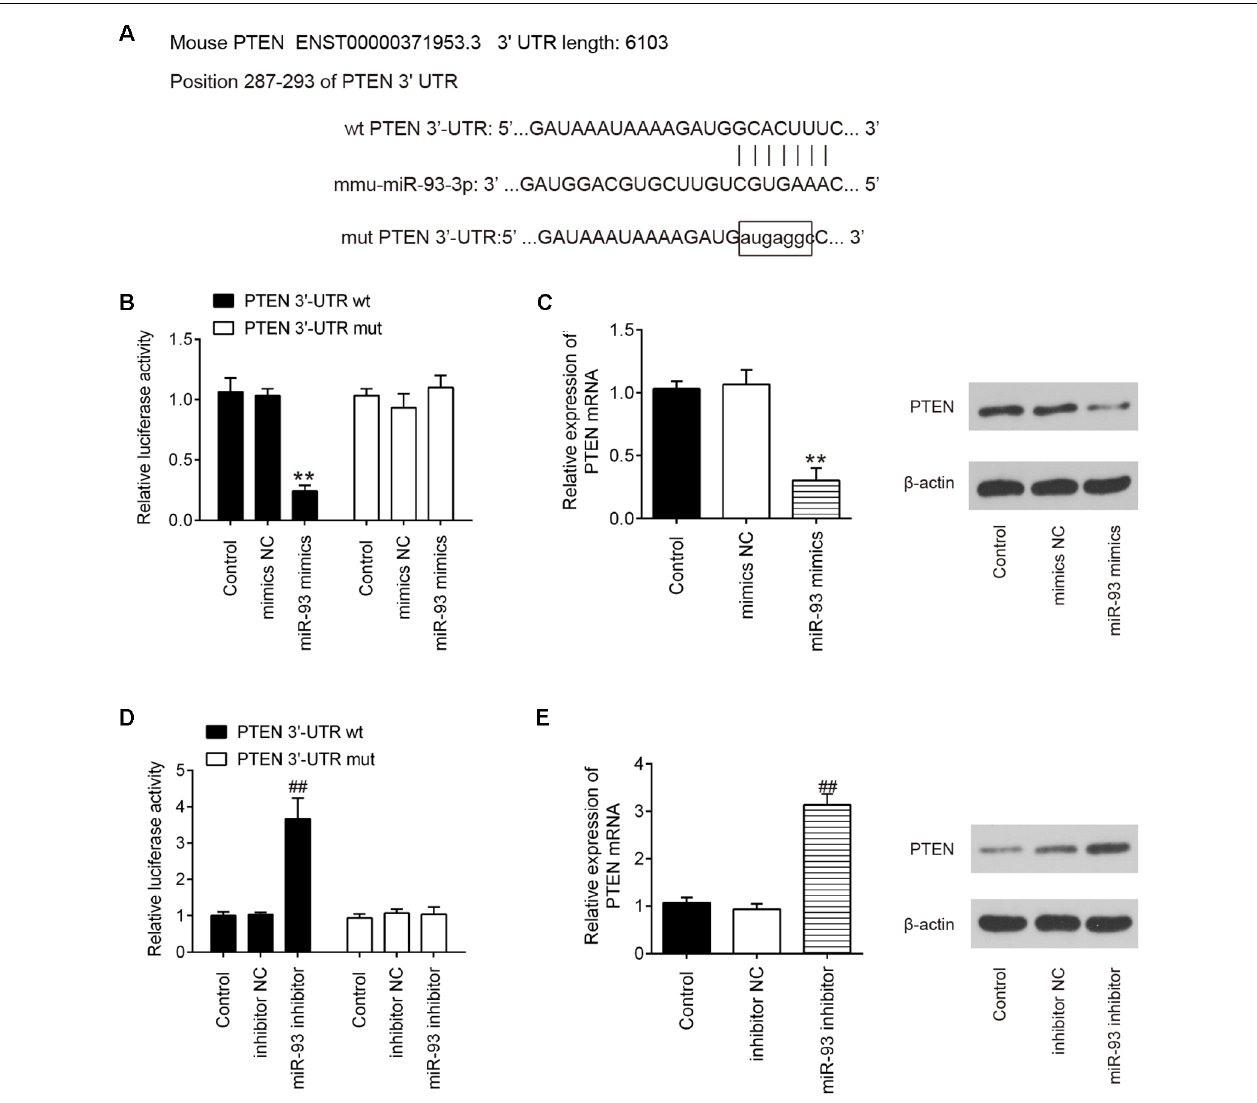
FIGURE 5 | Phosphatase and tensin homolog (PTEN) is a direct target of miR-93 in HT22 cells. (A) Putative miR-93 binding sites on 3 (cid:48) -UTR of PTEN mRNA were predicted. (B,D) Relative luciferase activity of HT22 cells cotransfected with miR-93 mimics/inhibitor and PTEN-3 (cid:48) -UTR-WT or PTEN-3 (cid:48) -UTR-MUT plasmid. (C,E) mRNA and protein expression levels of PTEN in HT22 cells transfected with miR-93 mimics/inhibitor. Data represent the mean ± SD of three independent experiments. ** p < 0.01 vs. mimics negative control (NC) group; ## p < 0.01 vs. inhibitor NC